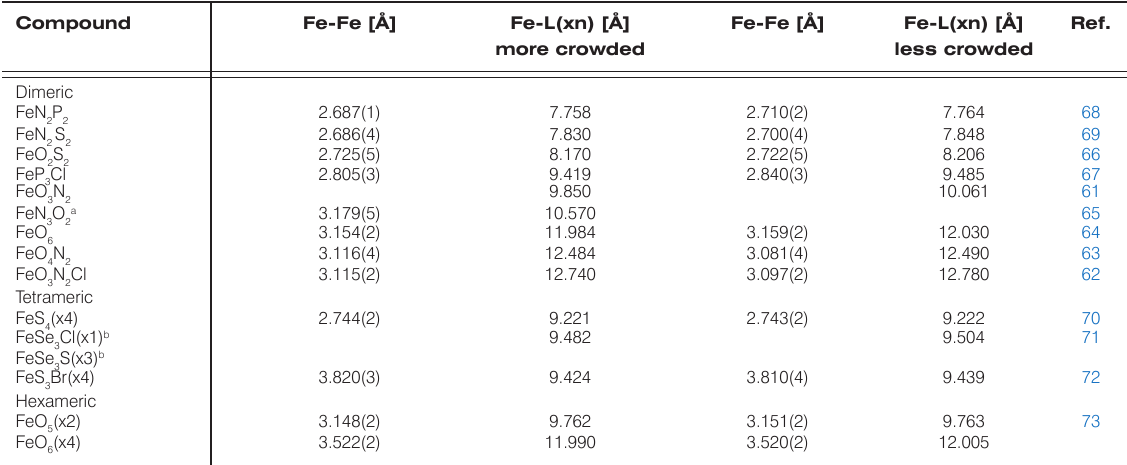
Table 5. Summary of the mean Fe-Fe distances and the sum of Fe-L(xn) (n = 4, 5 or 6) bond distances Compound Fe-Fe